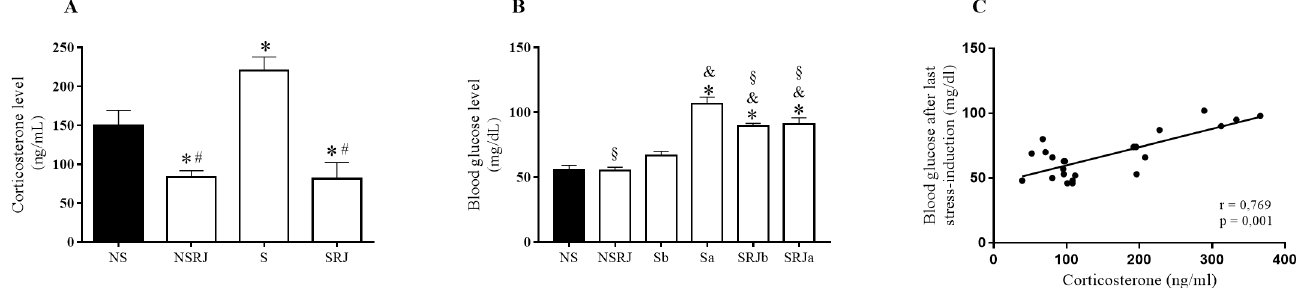
Fig 1. Biomarkers of chronic stress in liver tissue of rats stressed by restraint and cold. Plasma corticosterone level after seven days of stress-induction (A). No stress (NS), No Stress supplemented with Royal Jelly (NSRJ), Stress (S) and Stress supplemented with Royal Jelly (SRJ). Blood glucose level before and after the last stress induction (B). No stress (NS), No Stress supplemented with Royal Jelly (NSRJ), Stress group before the last stress session (Sb), Stress group after the last stress session (Sa), Stress group supplemented with RJ before the last stress session (SRJb), Stress group supplemented with RJ after the last stress session (SRJa). Pearson correlation of mean values of corticosterone levels and blood glucose after the last stress-induction (C). Values are expressed as means ± SEM. (cid:3) p < 0.05 vs NS, # p < 0.05 vs S, & p < 0.05 vs Sb, § p < 0.05 vs Sa (One-way ANOVA followed by Tukey test). Outliers were detected by performing Grubb’s test using an online GraphPad outlier calculator